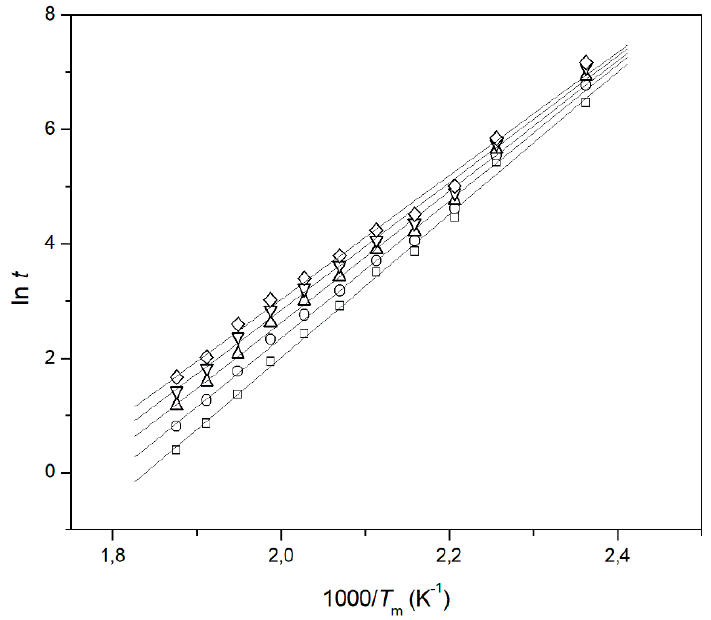
Figure 7. MacCallum straight lines at various D values: 5% ( ), 7.5% ( ), 10% ( ), 12.5% ( σ ), and 15% ( ) for Sample 9a .